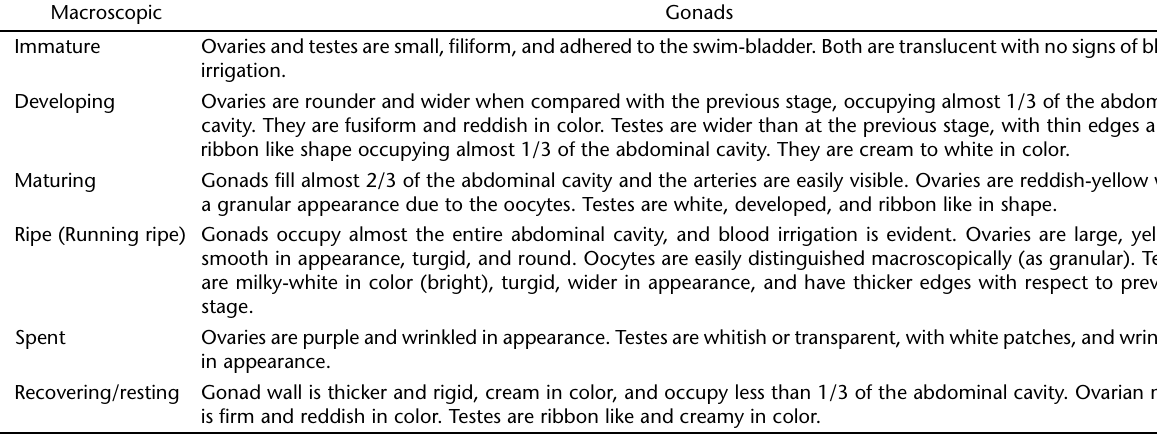
Table I. Macroscopic description of gonad stages of M. liza from the Sepetiba Bay. Macroscopic Gonads Immature Ovaries and testes are small, filiform, and adhered to the swim-bladder. Both are translucent with no signs of blood irrigation. Developing